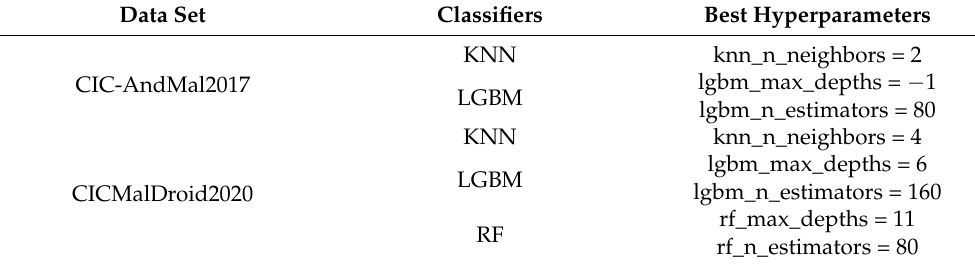
Table 5. The selected hyperparameters by GA.